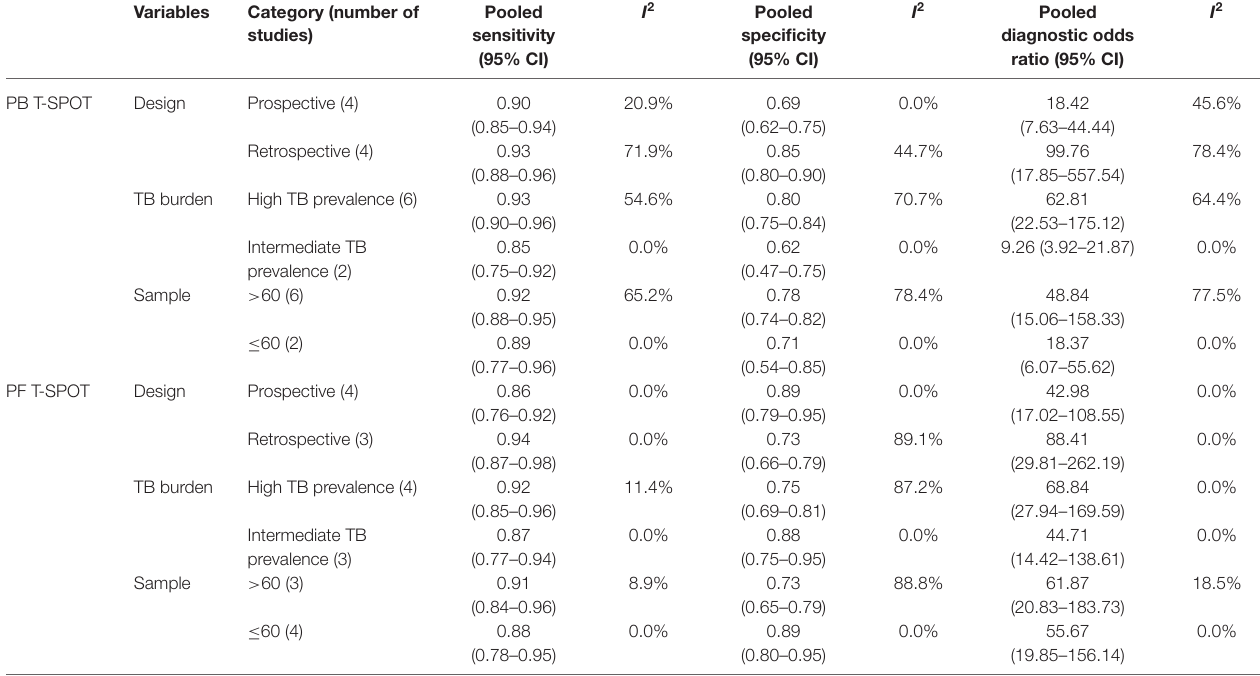
TABLE 2 | Subgroup analyses for exploration of factors influencing heterogeneity in T-SPOT assay. Variables